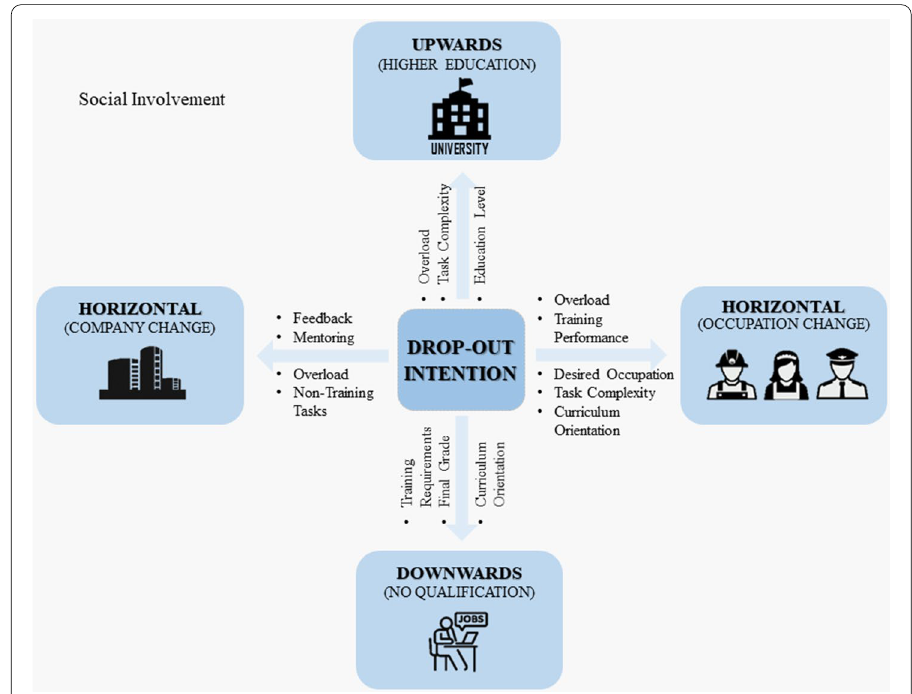
Fig. 3 Two-tier-scheme of influence factors for different directions of drop-out